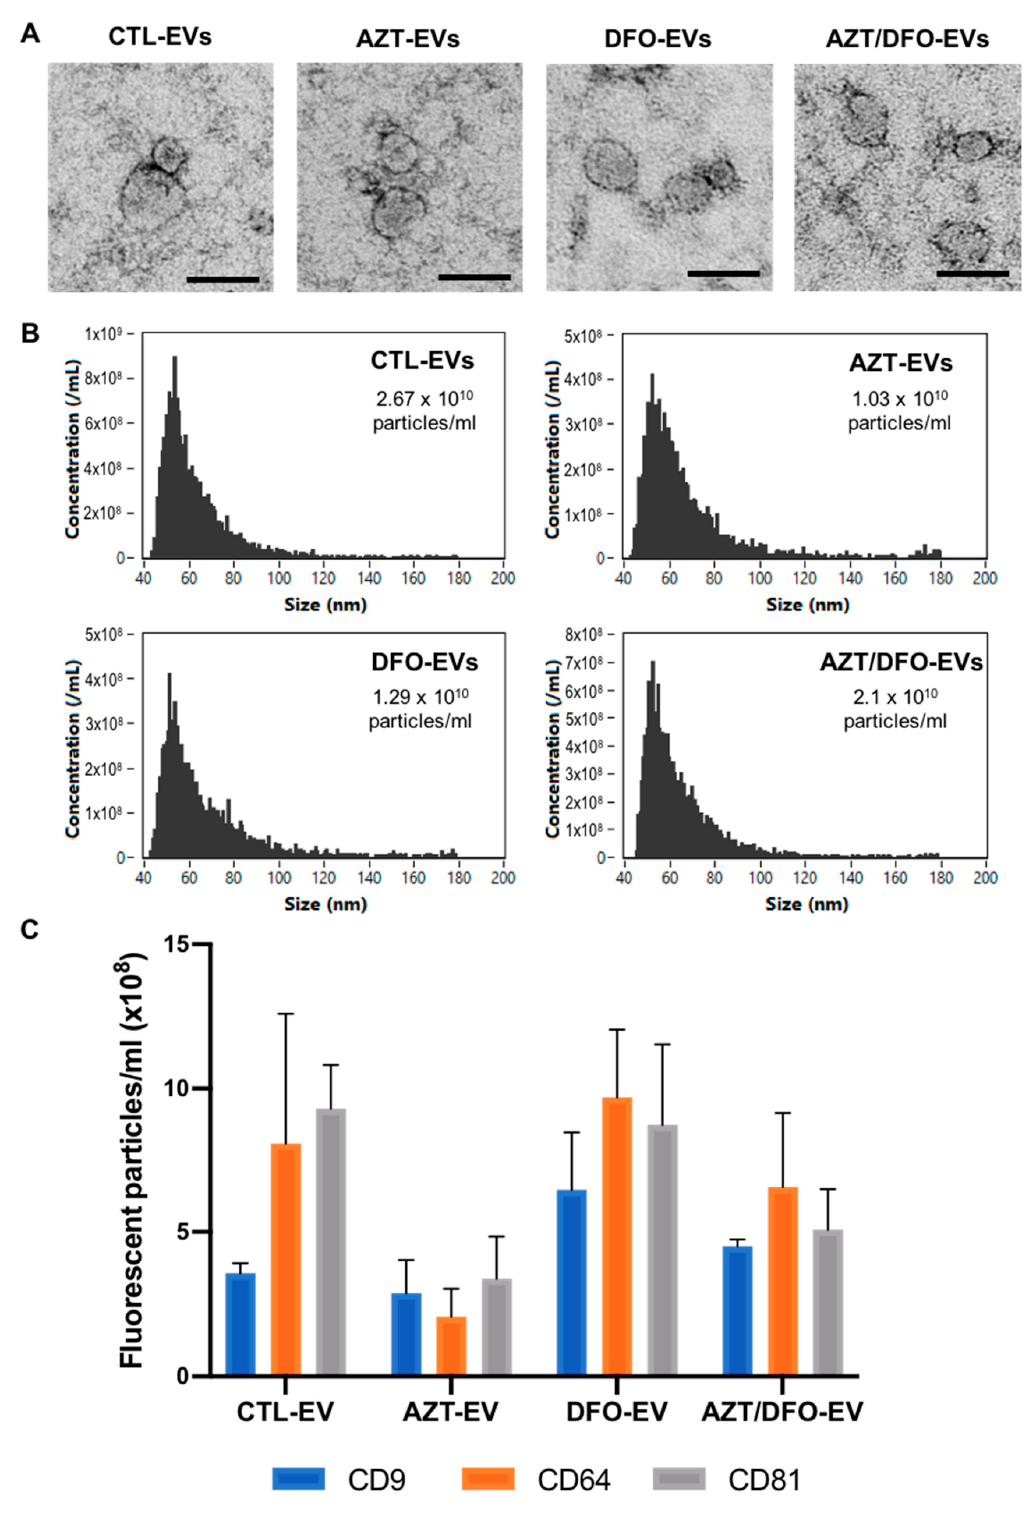
Figure 5. The characterisation of EVs isolated from AZT/DFO-treated hBMSCs. ( A ) TEM images of isolated EVs. Scale bar = 50 nm. ( B ) Nano-flow cytometry analysis, depicting the size distribution and concentration of particles. ( C ) Single-particle phenotyping of hBMSC-derived EVs. EVs were fluorescently labelled with APC-conjugated antibodies specific to CD9, CD63 and CD81. Data are expressed as mean ± SD ( n = 3).